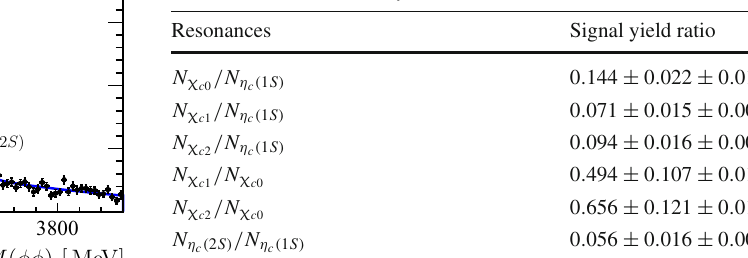
c states. The first uncertainties are